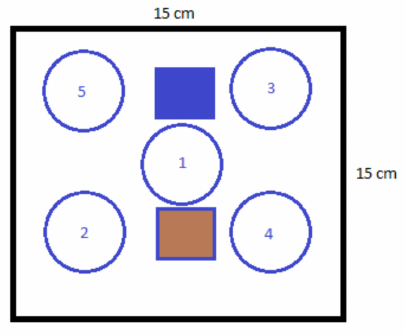
Figure 6. The sampling from the membrane under analysis—circular samples: 1 to 5 and the brown and blue